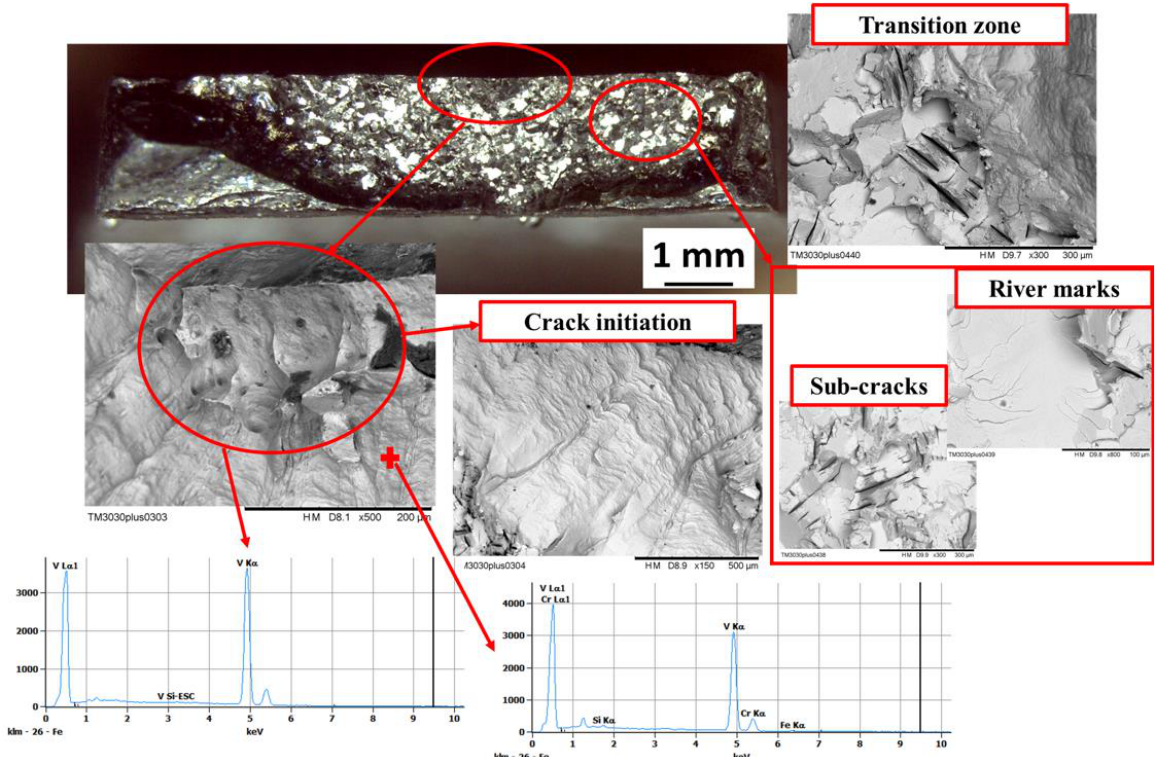
Figure 15. Fracture surface and EDS of the specimen tested at Δσ = 220 MPa and failed at 149,345 cycles (specimen 9).